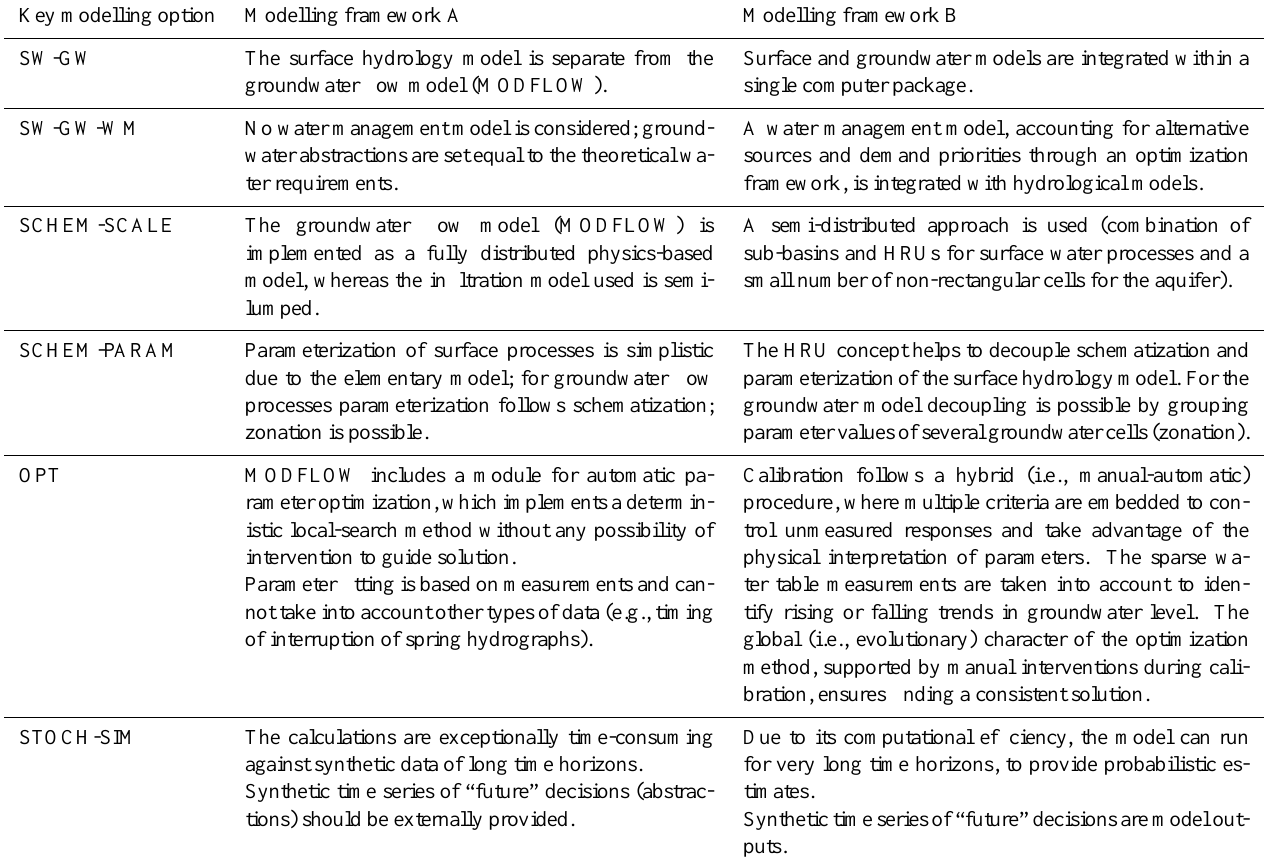
Table 1. Features of test modelling frameworks in regard to key modelling